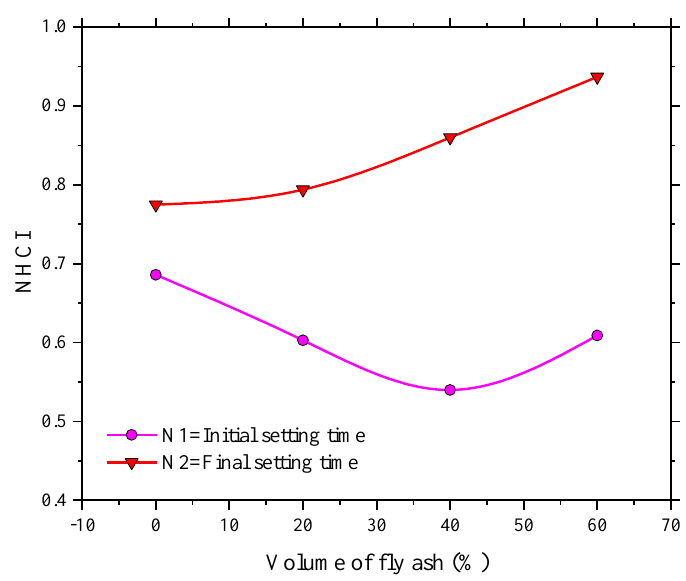
Figure 20. Influence of volume of fly ash in SCCs on NHCI values at initial and final setting times.